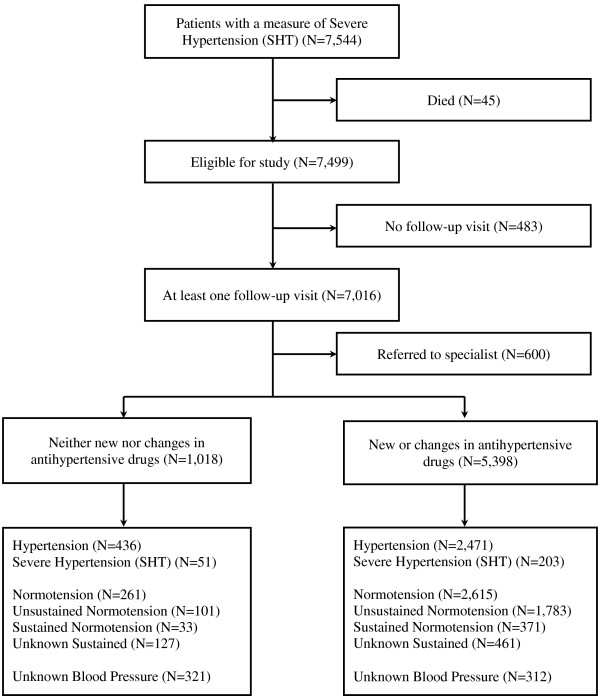
Summary illustration of the numbers of patients with severe hypertension (SHT) with respect to follow-up, referral, changes in antihypertensive drugs treatment and blood pressure (BP) control during the year of follow-up.